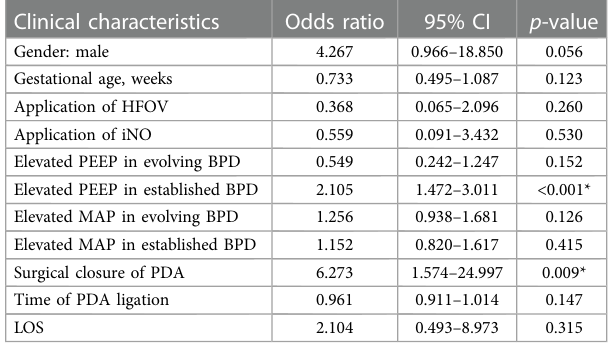
TABLE 4 Factors associated with BPD – PH in very low birth weight infants based on multivariate logistic analysis. Clinical